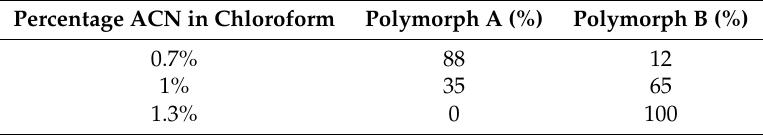
Table 1. Polymorphs’ percentage present in single crystals grown for di ff erent solution mixtures of ACN and CHCl 3 . The reported values were determined by means of single crystal X-ray di ff raction.